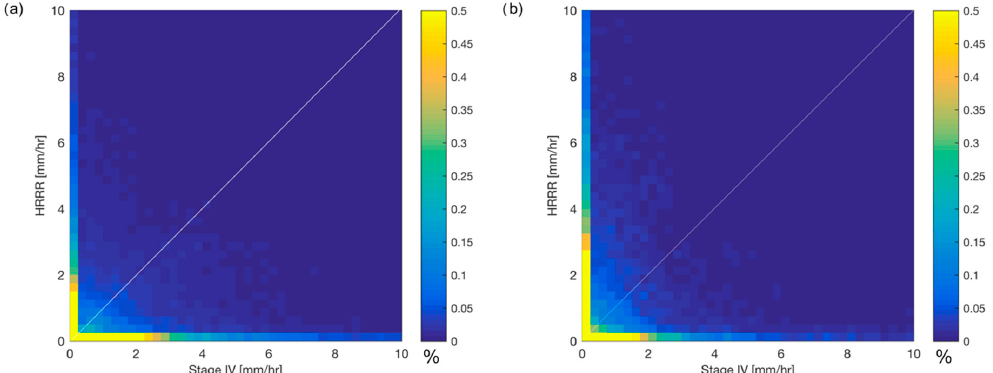
Figure 6. Two-dimensional histogram of precipitation from the HRRR hourly precipitation forecast versus Stage IV analyzed hourly precipitation for ( a ) the 30 July 2016 event and ( b ) 27 May 2018 event. The white diagonal line corresponds to a 1:1 line, where the model forecast would verify perfectly with the observation at all locations in the forecast domain.